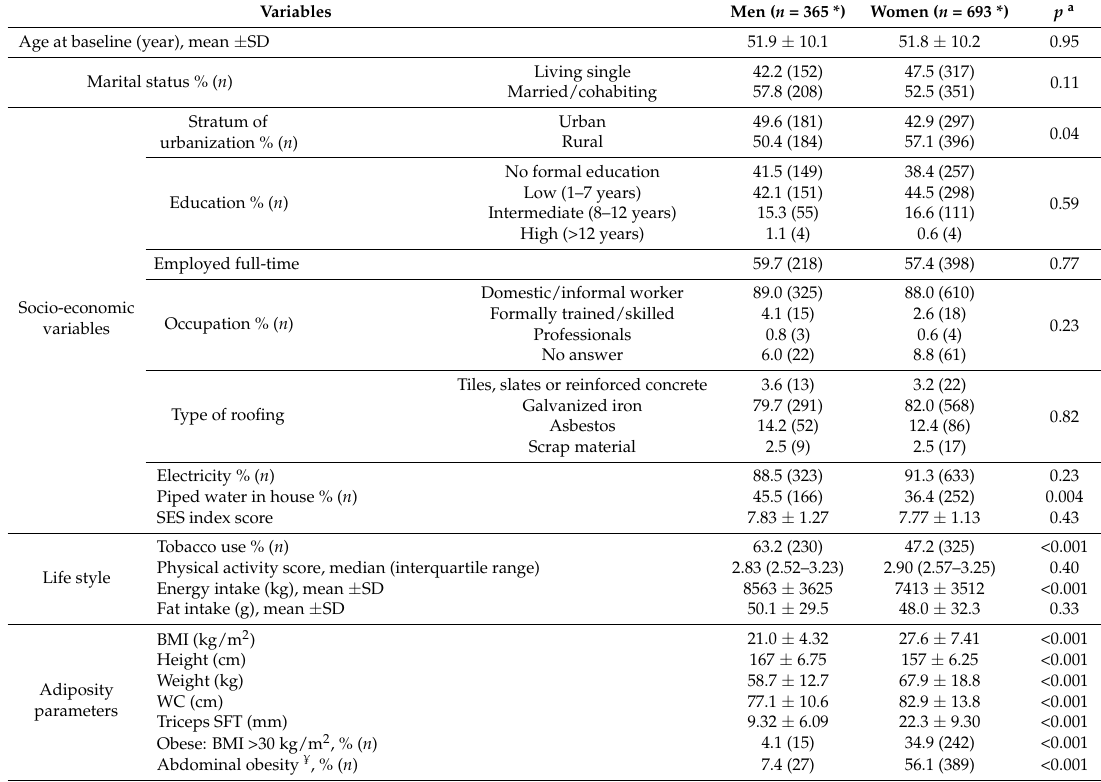
Table 1. Baseline descriptive data stratified according to